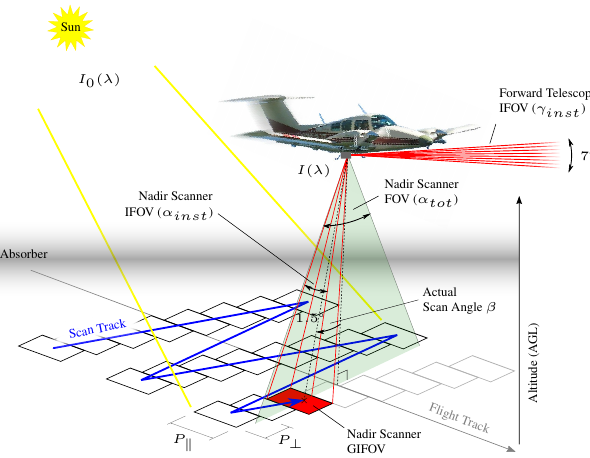
Figure 2. Schematic showing the measurement principle of the HAIDI system in the configuration for low flying aircraft (e.g., Flight Design CTLS, see Sect. 5.1), which uses a whiskbroom scan- ner in nadir direction and a pushbroom scanner in forward direction. The instantaneous field of view of the two telescopes ( α inst , γ inst ) is marked in red. While the whiskbroom scanner uses a sweeping prism to rotate the viewing direction of the nadir telescope by an- gle β across track direction, resulting in the total FOV α tot (green), the forward-looking telescope observes multiple viewing angles at